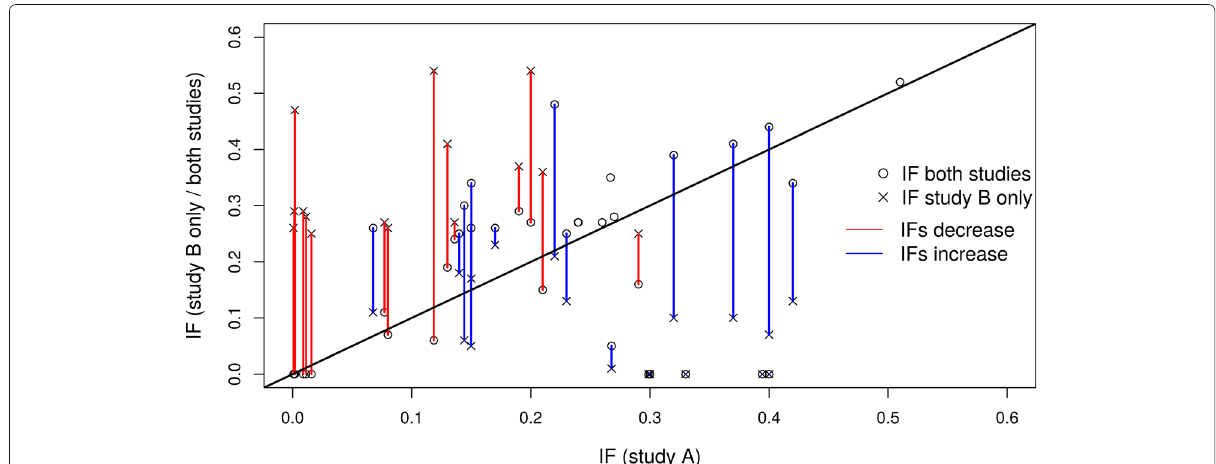
Fig. 2 This illustration shows how combining information from both studies A and B changes the inclusion frequency (IF) in comparison to IFs in both single studies